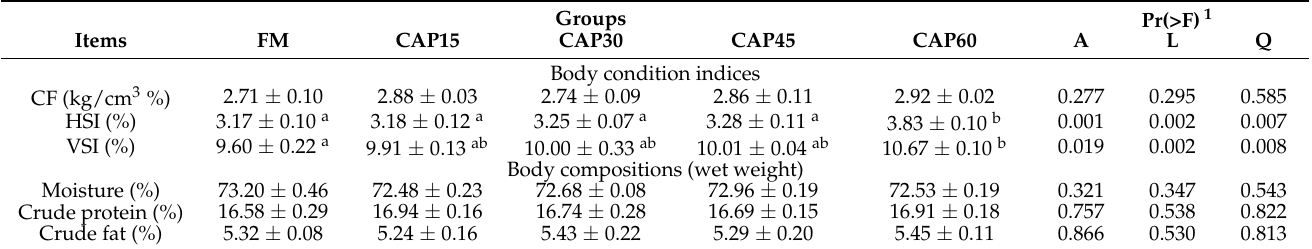
Table 4. Whole fish composition of pearl gentian grouper-fed gradient substitution of fishmeal in the diet with